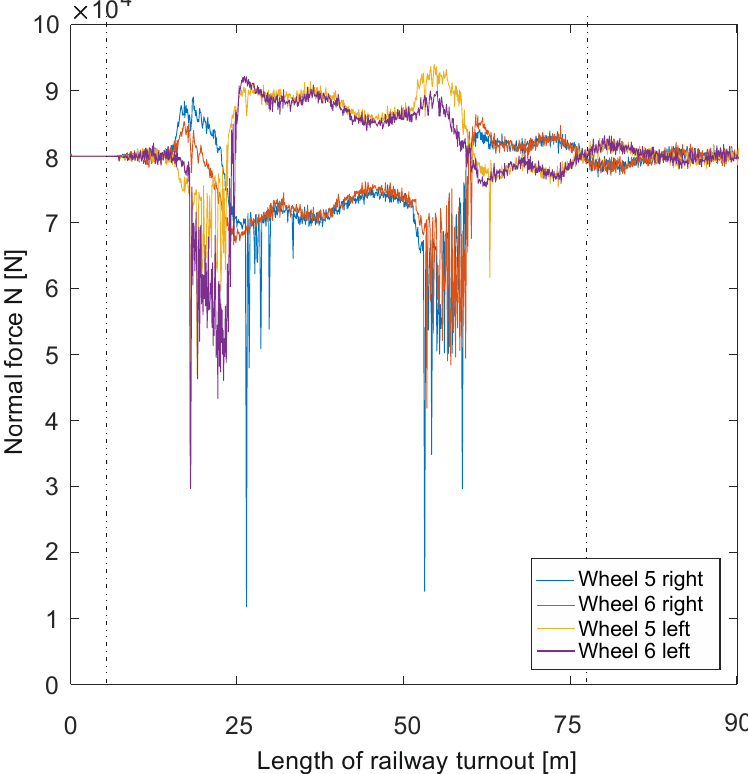
Figure 14. Normal force at 200 km/h on a straight track through a turnout.